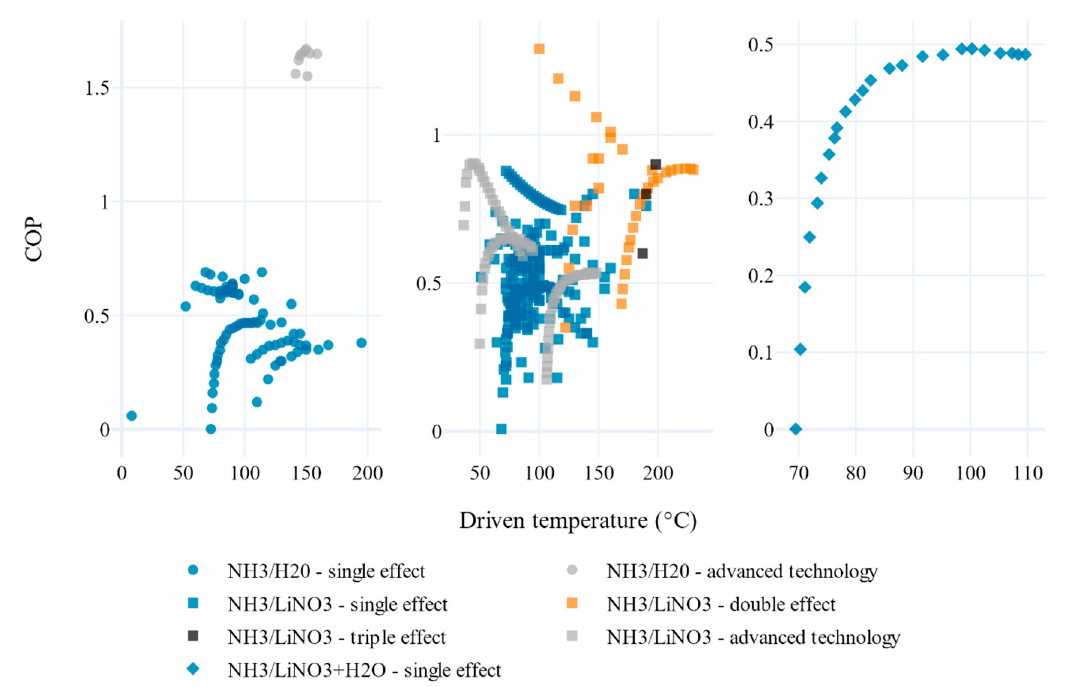
Figure 16. COP against driving temperature for each of the three working fluids (NH 3 /H 2 O, NH 3 /LiNO3, and NH 3 /LiNO 3 + H 2 O) and each of the four technologies (single, double, triple, and advanced technology).